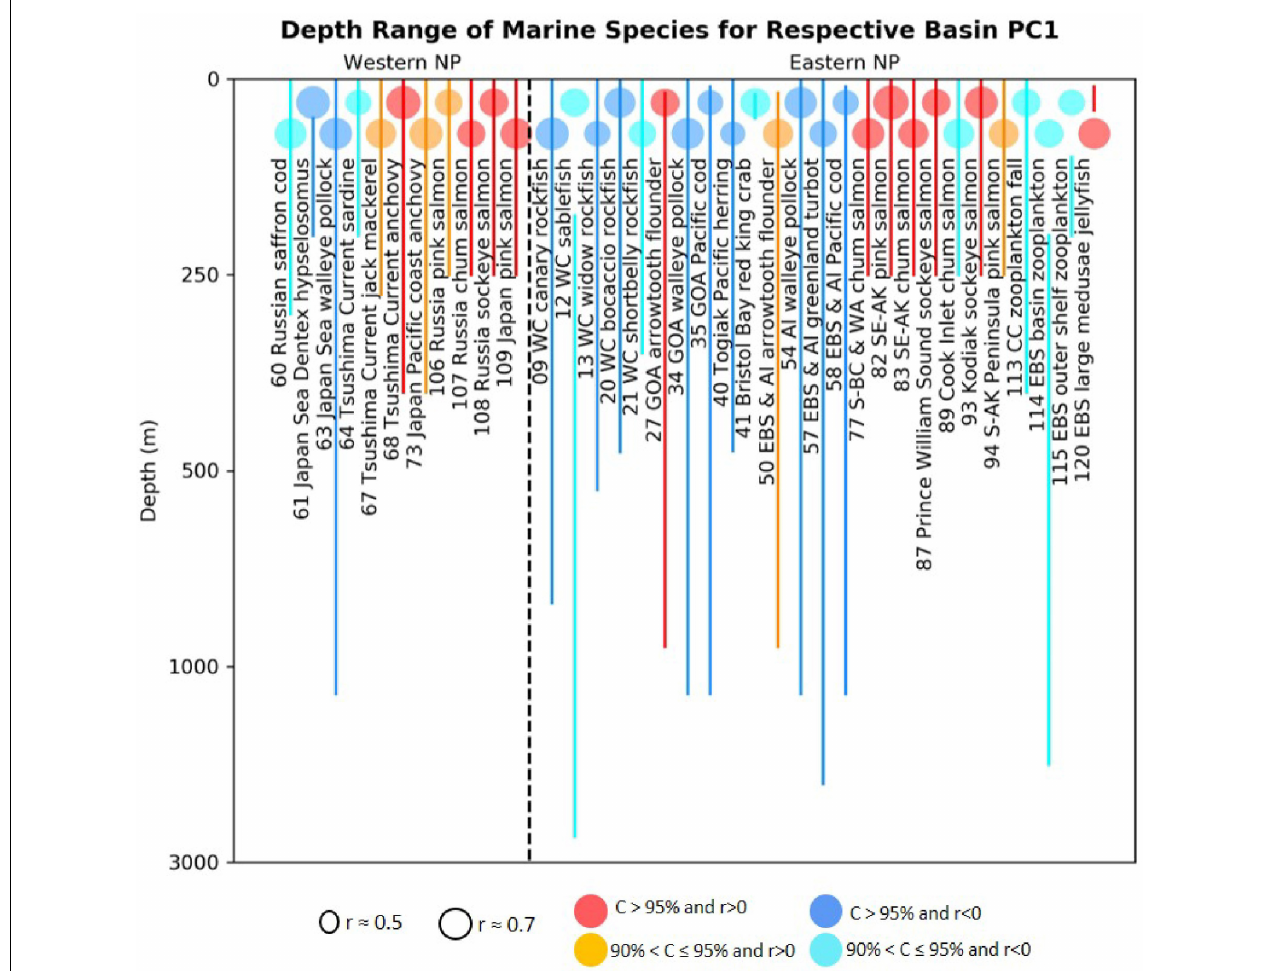
FIGURE 8 | Depth ranges (lines) of western and eastern basin marine species that have statistically significant correlations (colored circles) with respective basin PC1s. The colored circles indicate the absolute correlations and color indicates the corresponding confidence levels as in Figure 2 .